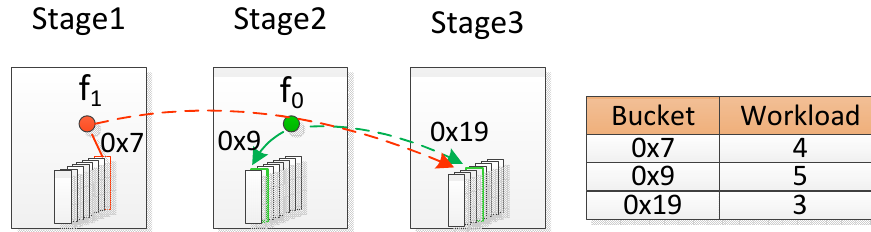
Figure 7. Data hazard during flowkey insertion.